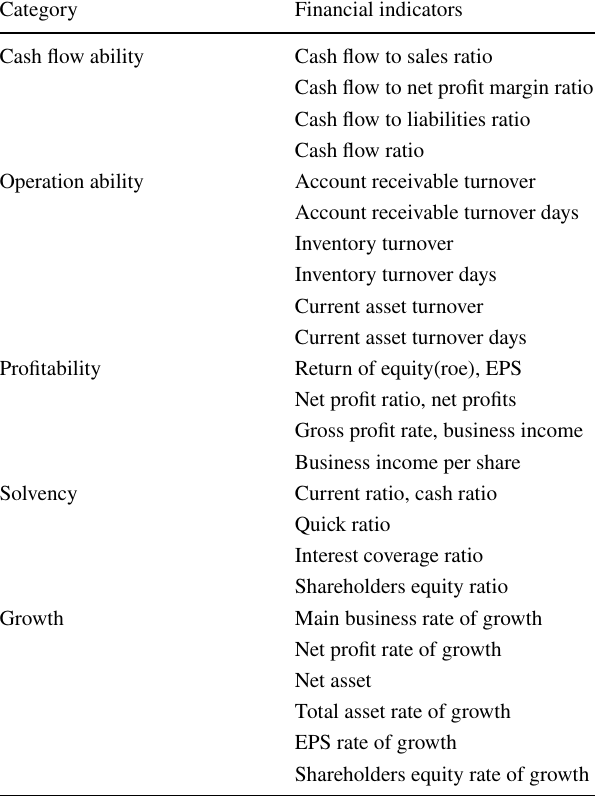
Table 1 The numerical financial indicators used in our experiments